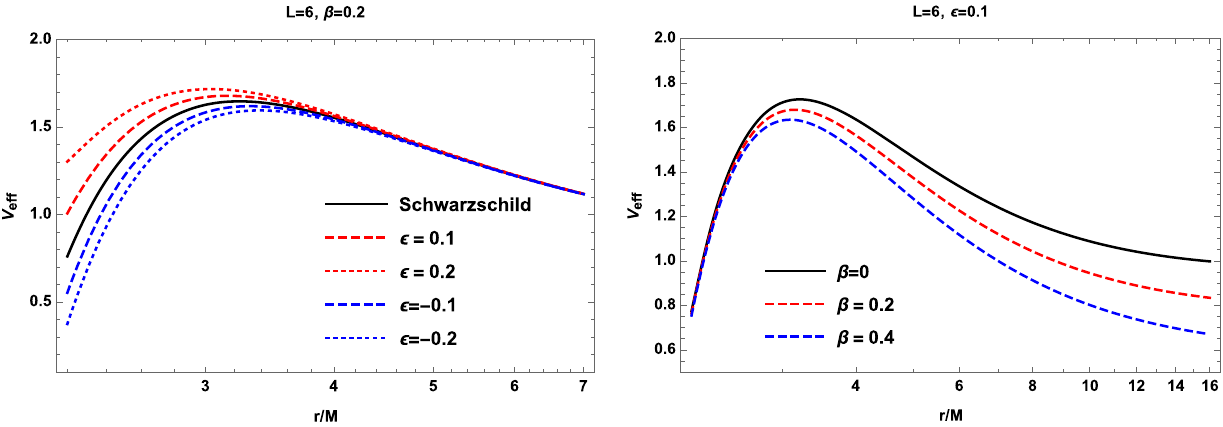
Fig. 6 Effective potential as a function of r / M for different values of the deviation (left panel) and the magnetic interaction (right panel) parameters